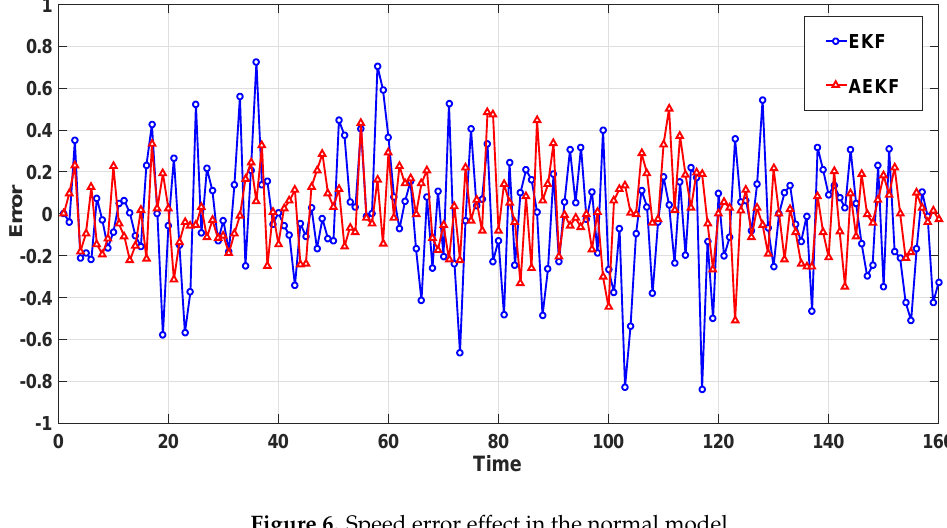
Figure 6. Speed error effect in the normal model. Table 2. Algorithmic errors in the normal